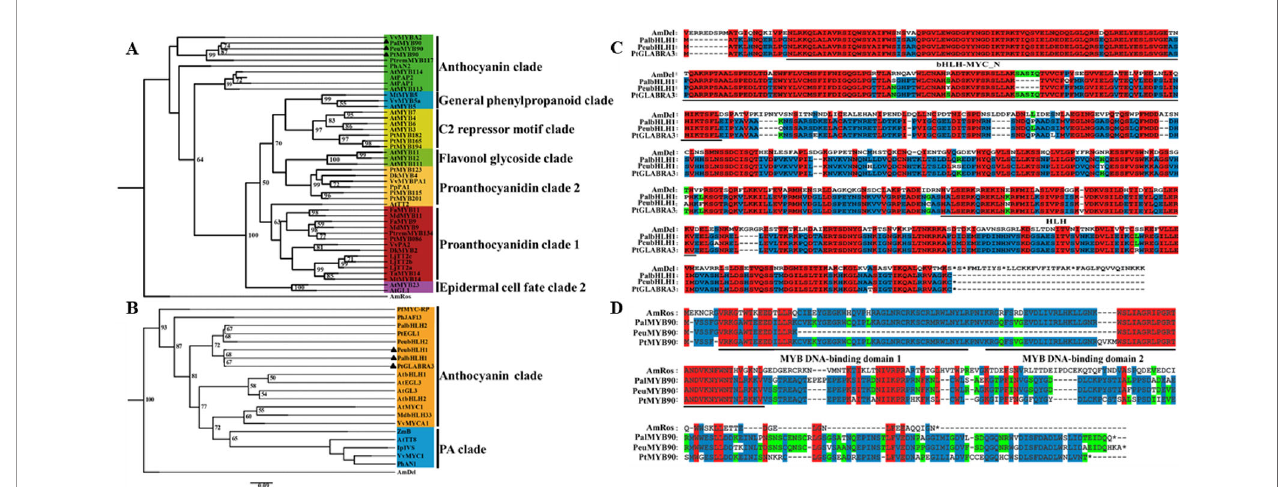
FIGURE 1 | Phylogenetic analyses and multiple alignments of PalbHLH1 and PalMYB90 . (A) Phylogenetic tree of MYB90 and selected R2R3-Myb proteins from other plant species obtained using the Maximum Likelihood (ML) method in MEGA v.5.1 software. (B) Phylogenetic tree of bHLH1 with other bHLH sequences. The scale bar represents 0.05 substitutions per site. (C , D) The bHLH domains of bHLH1 and R2R3-Myb of MYB90 are both labeled with black lines. Identical amino acids are shaded in red, and similar amino acids are shaded in blue and